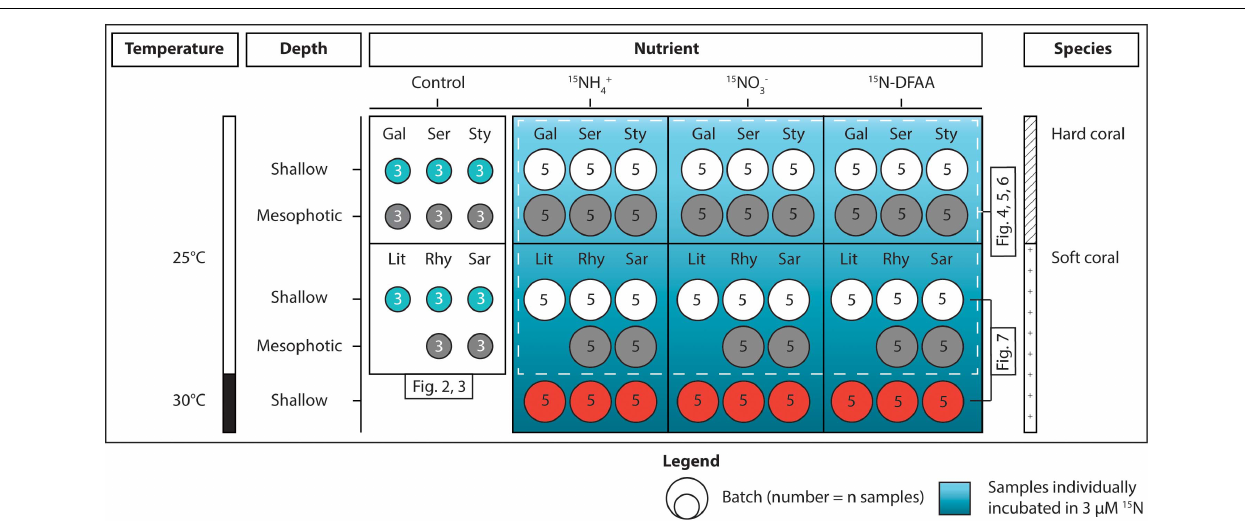
FIGURE 1 | Overview of the experimental design. Corals sampled at shallow and mesophotic depths were distributed across three conditions (Control, incubated in 15 N for 5 h, and maintained at 30 ◦ C for 1 week × incubated in 15 N for 5 h). The seawater used for the incubations was enriched with 3 µ M of either 15 NH 4 + , 15 NO 3 − , or 15 N-DFAA. The first three species [ Galaxea fascicularis (Gal), Seriatopora hystrix (Ser), Stylophora pistillata (Sty)] are hard corals and the last three [ Litophyton arboreum (Lit), Rhytisma fulvum fulvum (Rhy), Sarcophyton sp. (Sar)] are soft corals. Colors of the batches match with those displayed on the figures. DFAA = dissolved free amino